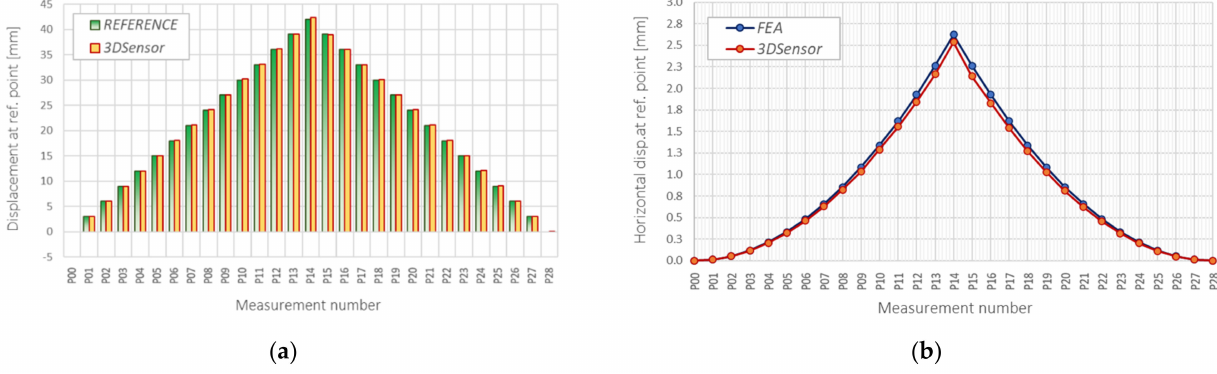
Figure 16. ( a ) Comparison of DFOS vertical displacements with reference micrometres; ( b ) comparison of DFOS horizontal shortenings with FEA results (see also Figures 1b and